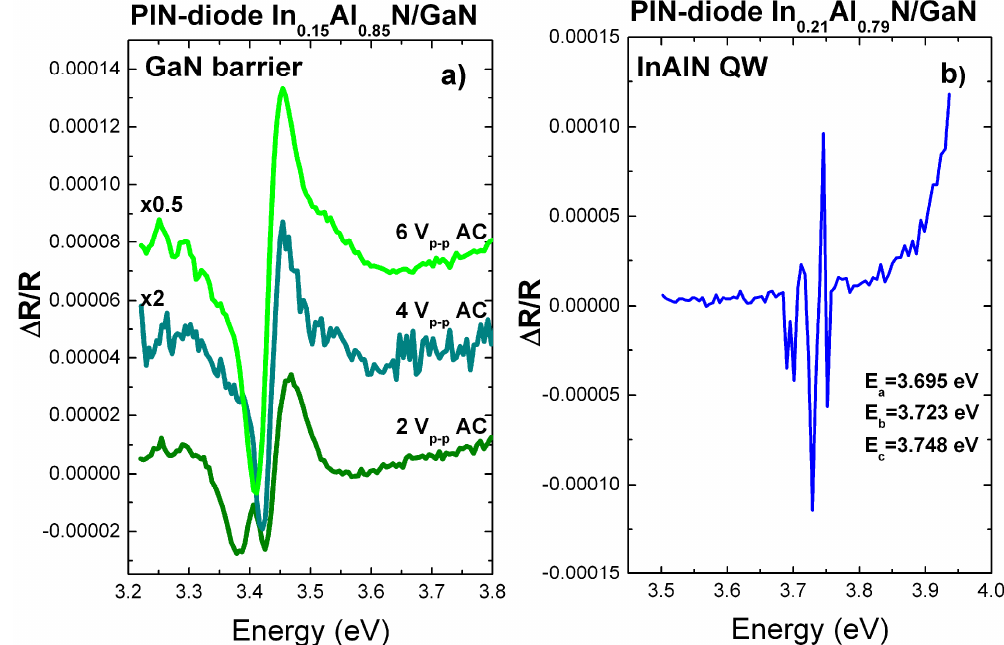
Figure 8. ER spectra of PIN-diodes based on In x Al 1-x N / GaN DHS: ( a ) selection of transition energies E a , E b , and E c of the GaN barrier in In 0.15 Al 0.85 N / GaN DHS by variation of AC bias-voltage and ( b ) transition energies E a , E b , and E c of InAlN in In 0.21 Al 0.79 N / GaN DHS.